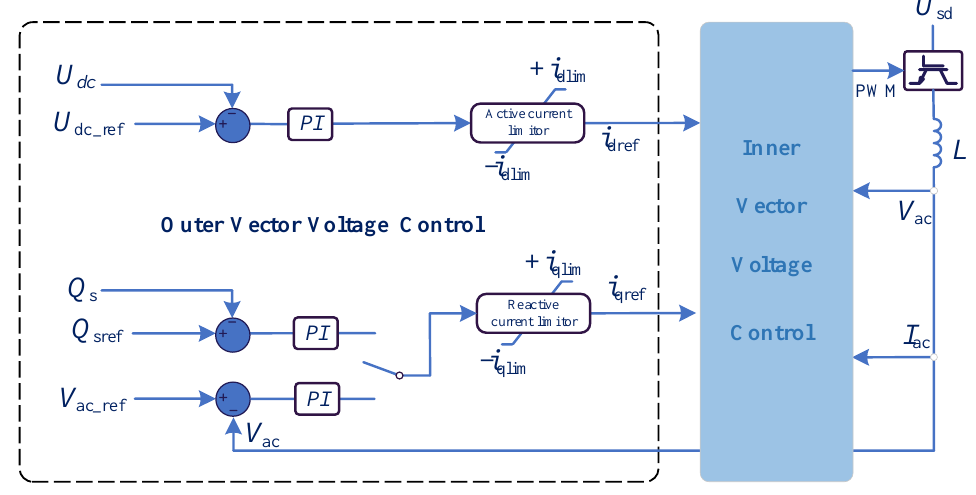
Figure 3. The control strategies of auxiliary-controlled converter in IPFC.